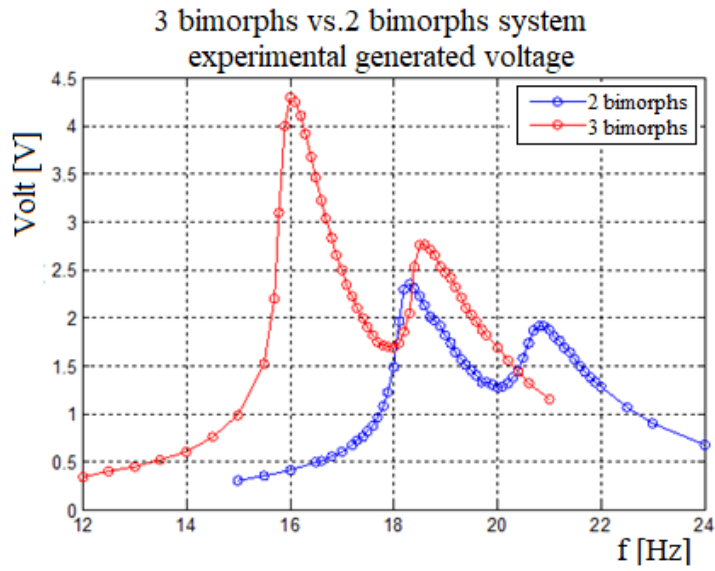
Figure 15. Three bimorphs vs. two bimorphs system—experimental generated voltage.